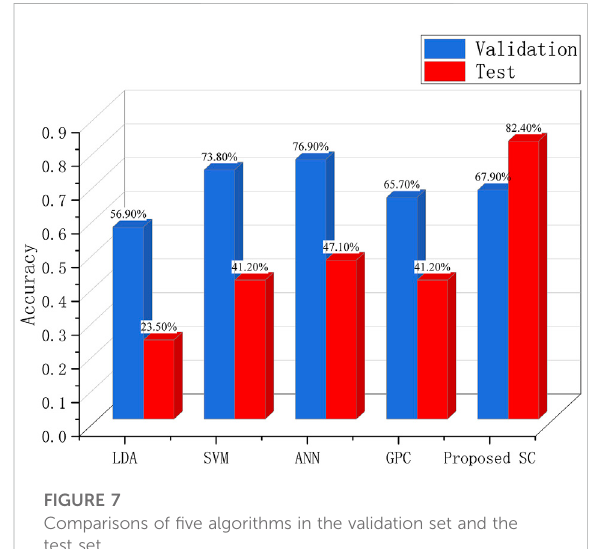
FIGURE 7 Comparisons of fi ve algorithms in the validation set and the test